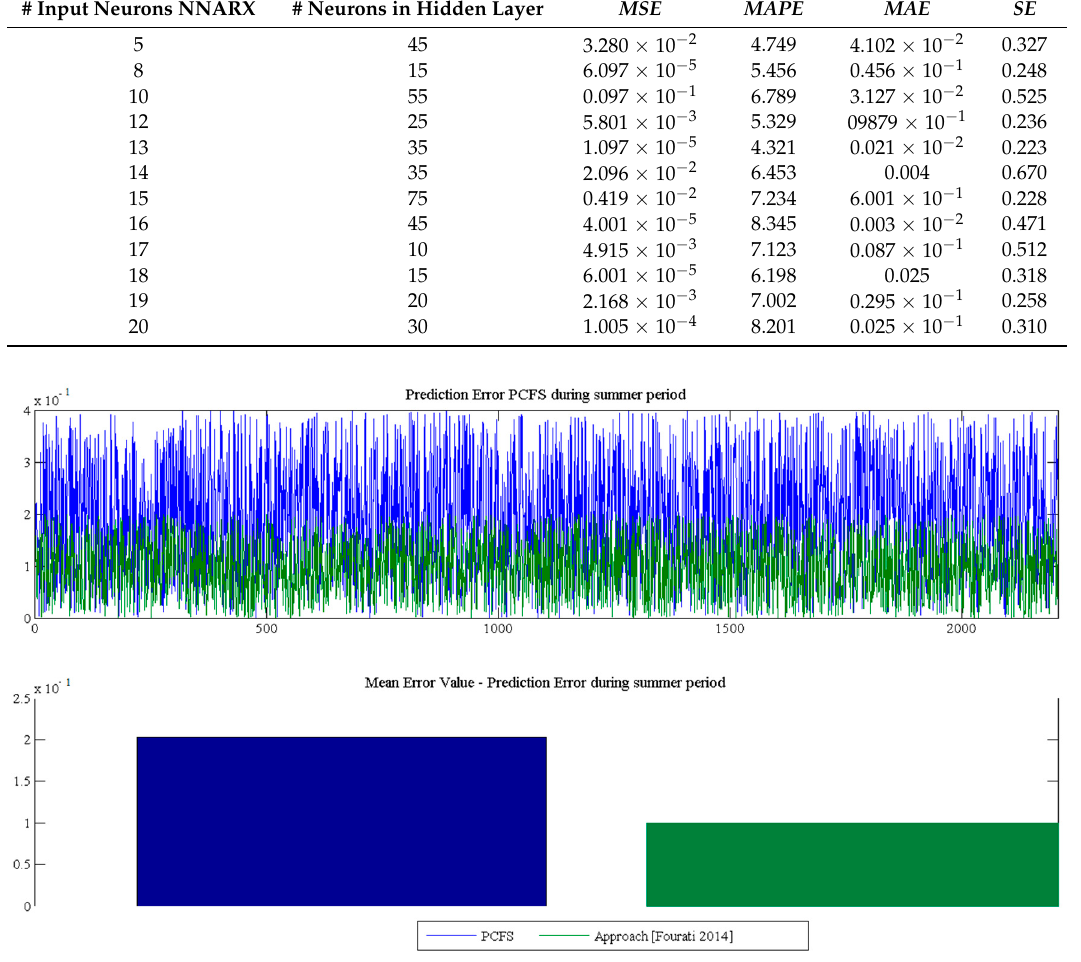
Figure 5. Error comparison during learning test.